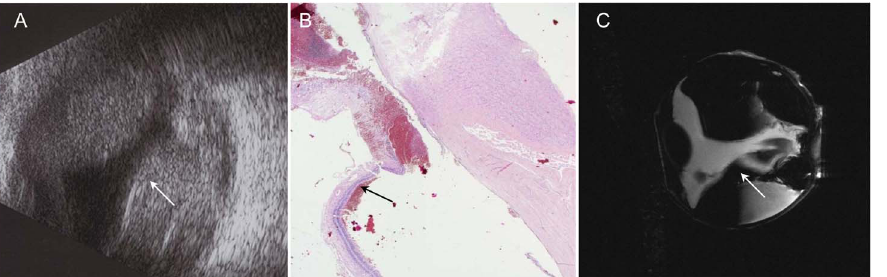
Figure 6. Hemorrhagic choroidal detachment (arrow). A – Sonography: Kissing bullae with high internal reflectivity. B – H&E stain, 2x: Portions of detached retina and choroid with blood underneath. C – Coronal T2w image: Very low internal signal intensity due to the presence of hemoglobin degradation products, fluid-fluid level in the lateral compartment.